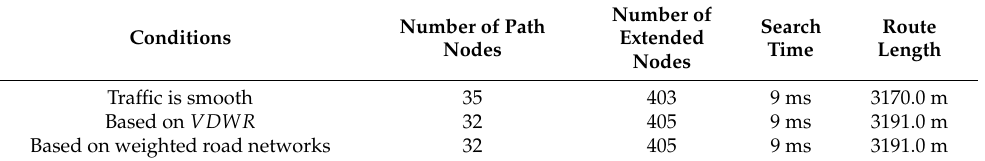
Table 3. Crowded Road is Located Near the Destination While Driving a Relatively Short Distance.